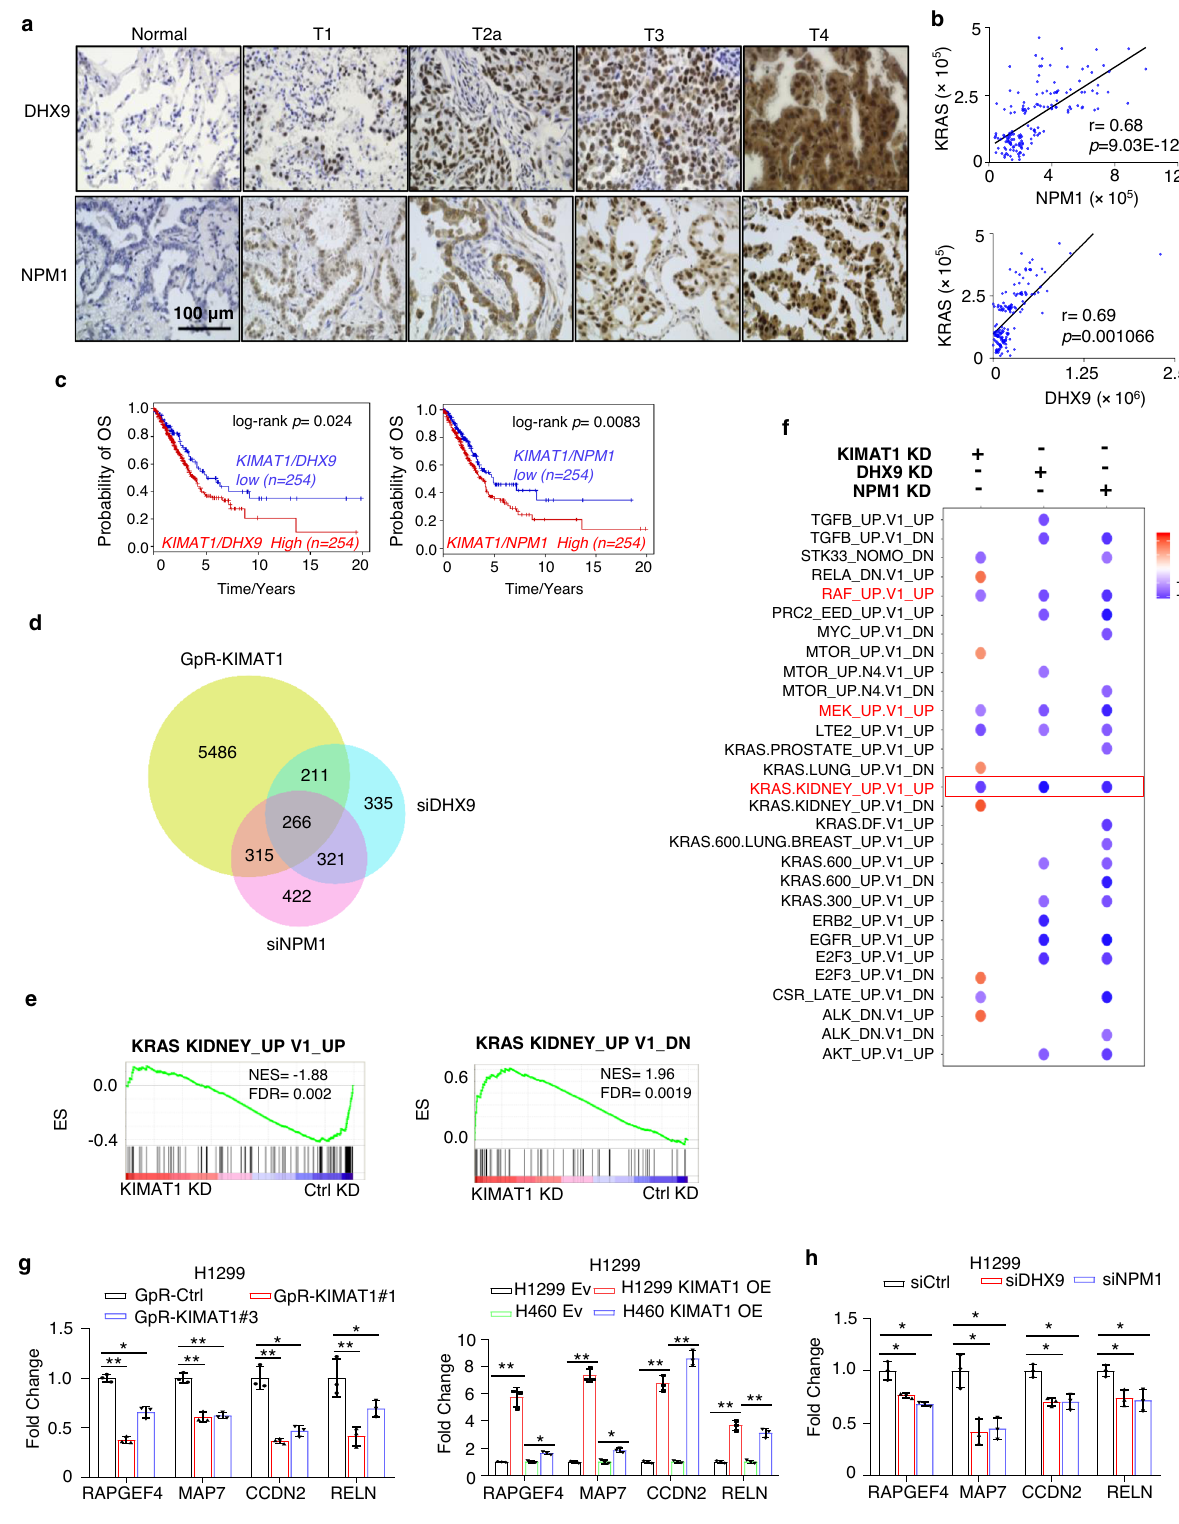
(Supplementary Fig. 11f). As for KIMAT1 , network analysis evidenced that genes belonging to pathways activated by DHX9 or NPM1 were predicted targets of DHX9- and NPM1- suppressed miRNAs (Fig. 6g and Supplementary Data 4). Altogether, these data suggest that KIMAT1 enhances the processing of a subset of miRNAs that foster lung cancer progression via DHX9 and